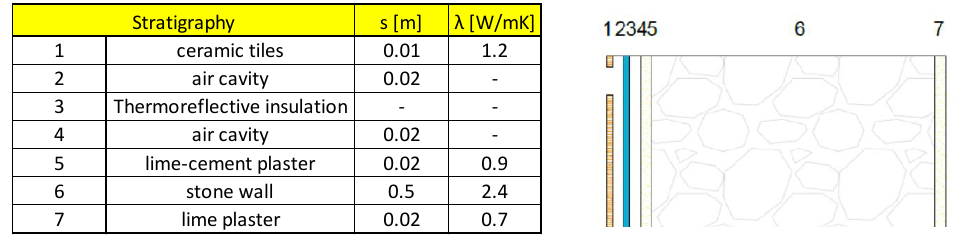
Figure A14. Wall type 5.1: transmittance check for the three main Italian climatic zones. In are blue the heat-reflective materials which respect all the limits.